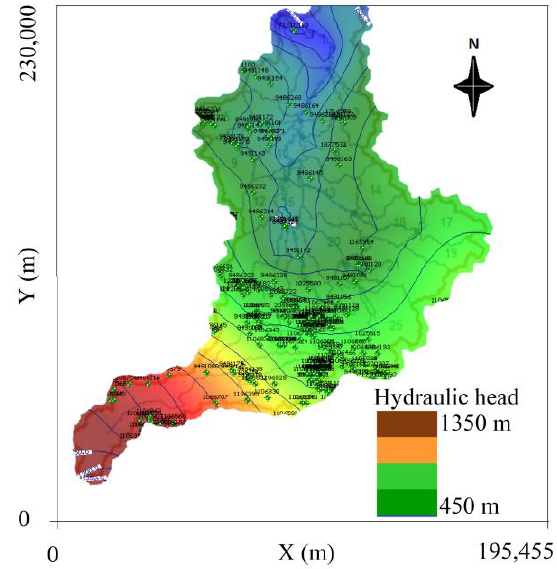
Figure 4. Contour map of the hydraulic head for the Little Smoky River watershed, produced by Visual MODFLOW. The hydraulic head roughly follows topography, with higher heads found in the upstream regions of the area. Each small number on the map represents a calibration well within the Little Smoky River watershed.